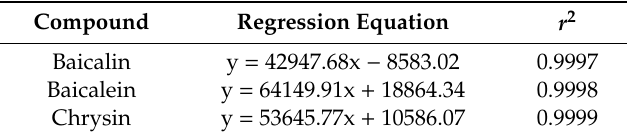
Table 3. Calibration data for baicalin, baicalein, and chrysin, including regression equations and correlation coefficient ( r 2 ).